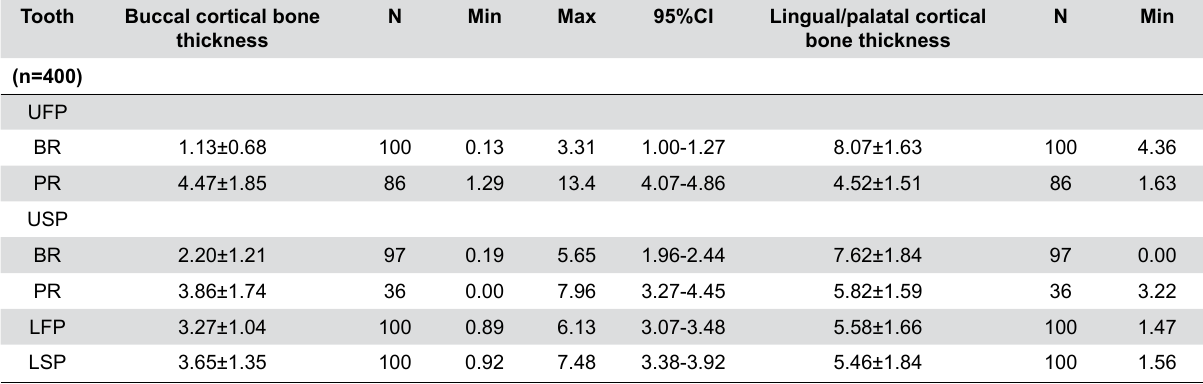
maxillary and mandibular premolar teeth. The smallest